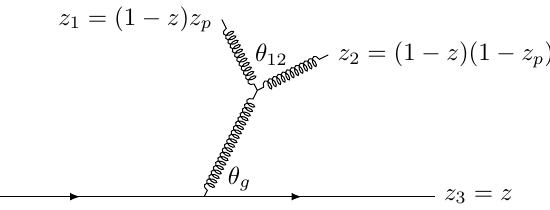
Figure 2 . The Feynman diagram representing the gluon decay C F C A channel. The mapping of the momentum fractions to a set of independent variables is explained in the text. The angle θ that between the parent gluon and the final-state quark.